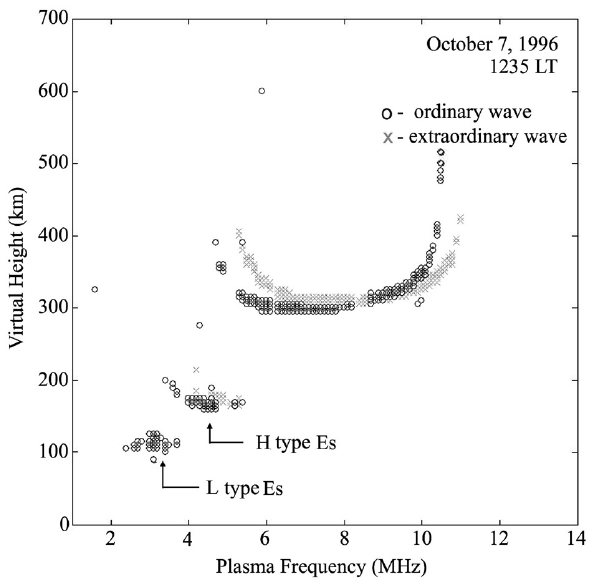
Fig. 1. Sample ionogram illustrating the sporadic-E (L type) and intermediate layer (H type) observation as seen by the digisonde system. The circle represents the ordinary wave, while the cross is the extraordinary wave.